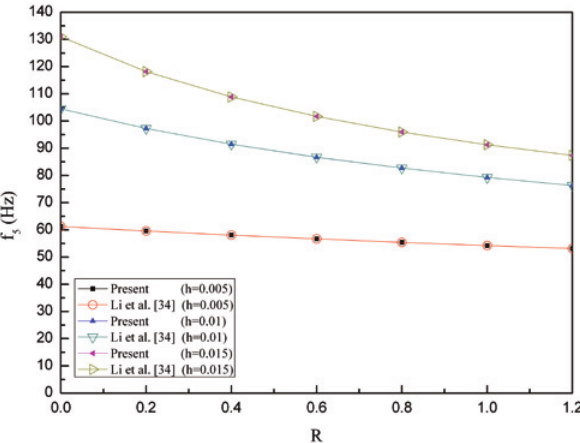
Figure 8 The fifth-order frequency of the clamped square compos- ite laminates with uniform bonding imperfections.